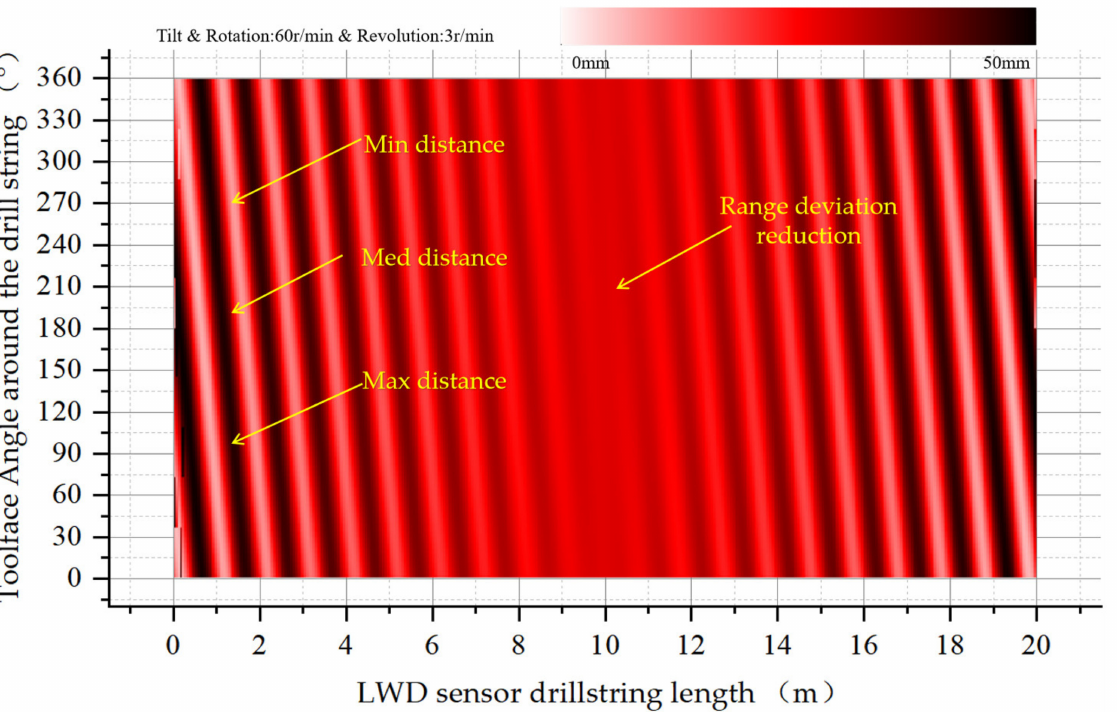
Figure 14. Eccentricity distribution of drill collars in the wellbore, with oblique rotation and additional revolution at a speed of 3